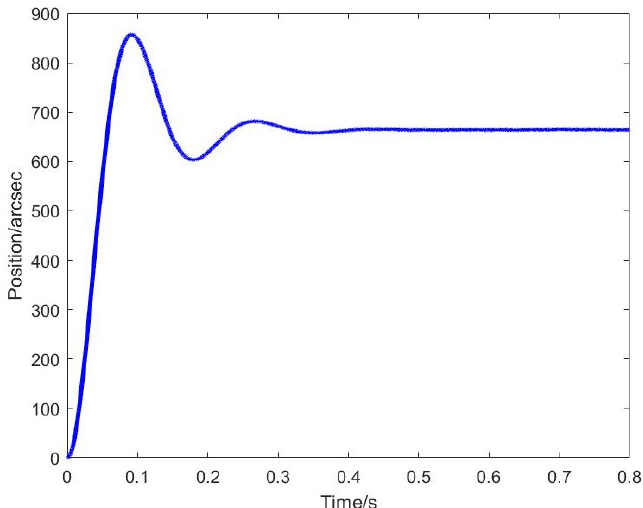
Figure 4. ETS open-loop step response output obtained on the experimental